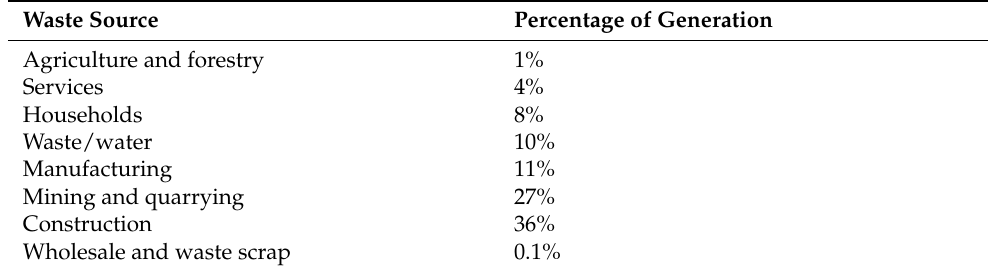
Table 1. European waste-producing areas. Source: own elaboration with data collected from Eurostat [14]. Waste Source Percentage of Generation Agriculture and forestry 1% Services 4% Households 8% Waste/water 10% Manufacturing 11% Mining and quarrying 27% Construction 36% Wholesale and waste scrap